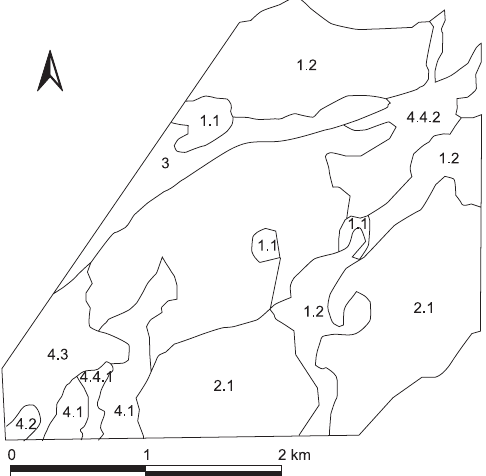
Fig. 3. Vegetation map of the study area within the Bly- deberg Conservancy. Map depicts the various communi- ties, sub-communities and